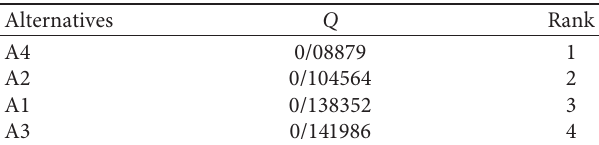
Table 12: Ranking alternatives.